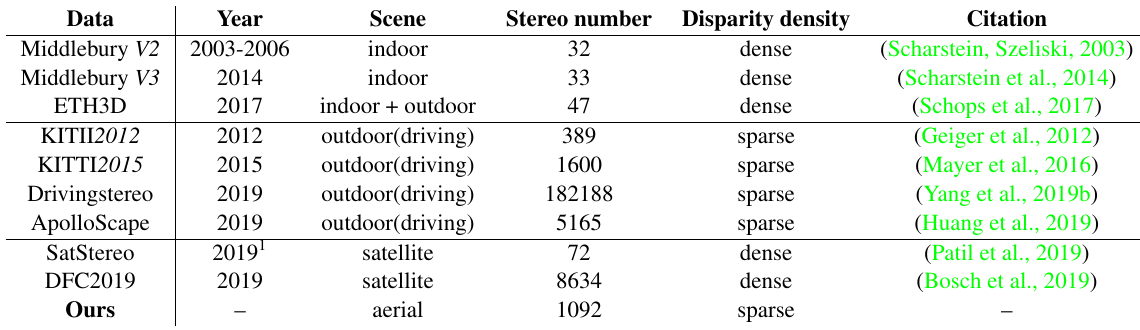
Table 1. Benchmark datasets for disparity estimation. Stereo number is the total number of stereo pairs used for both training and testing.